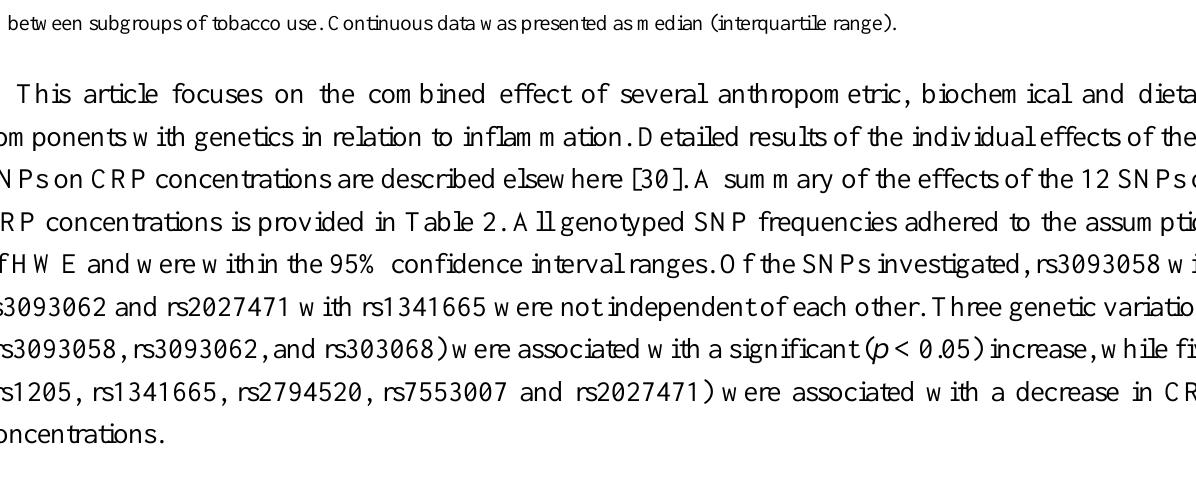
Table 2. Summary of the minor allele frequencies of the investigated CRP genotypes and their effects on CRP